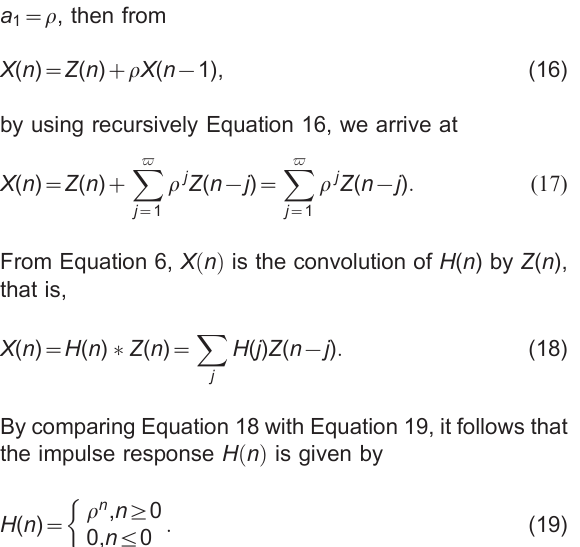
Figure 2 exemplifies the time averaging series, which were the sources used for derivation of the